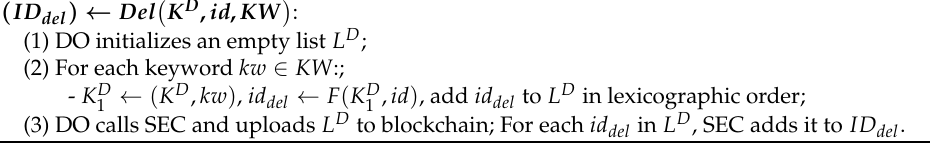
Figure 5. Part II of Π SE